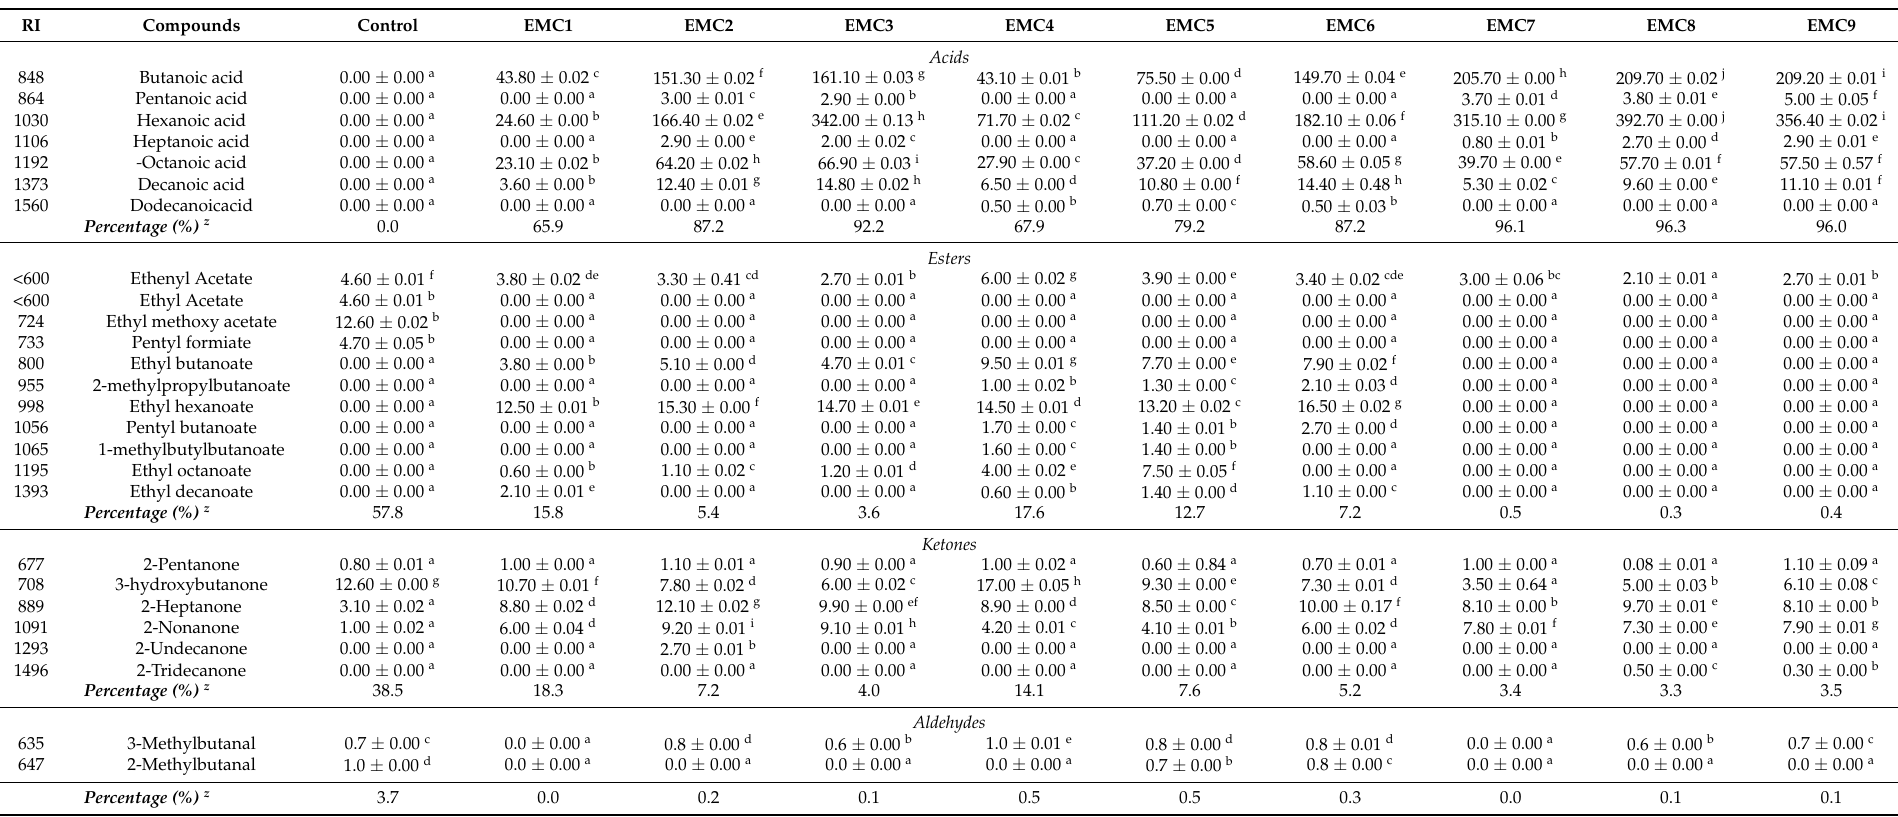
Table 4. Volatile compounds (AU × 10 7 ) were isolated from the control group and EMC products during lipolysis by three lipases) x